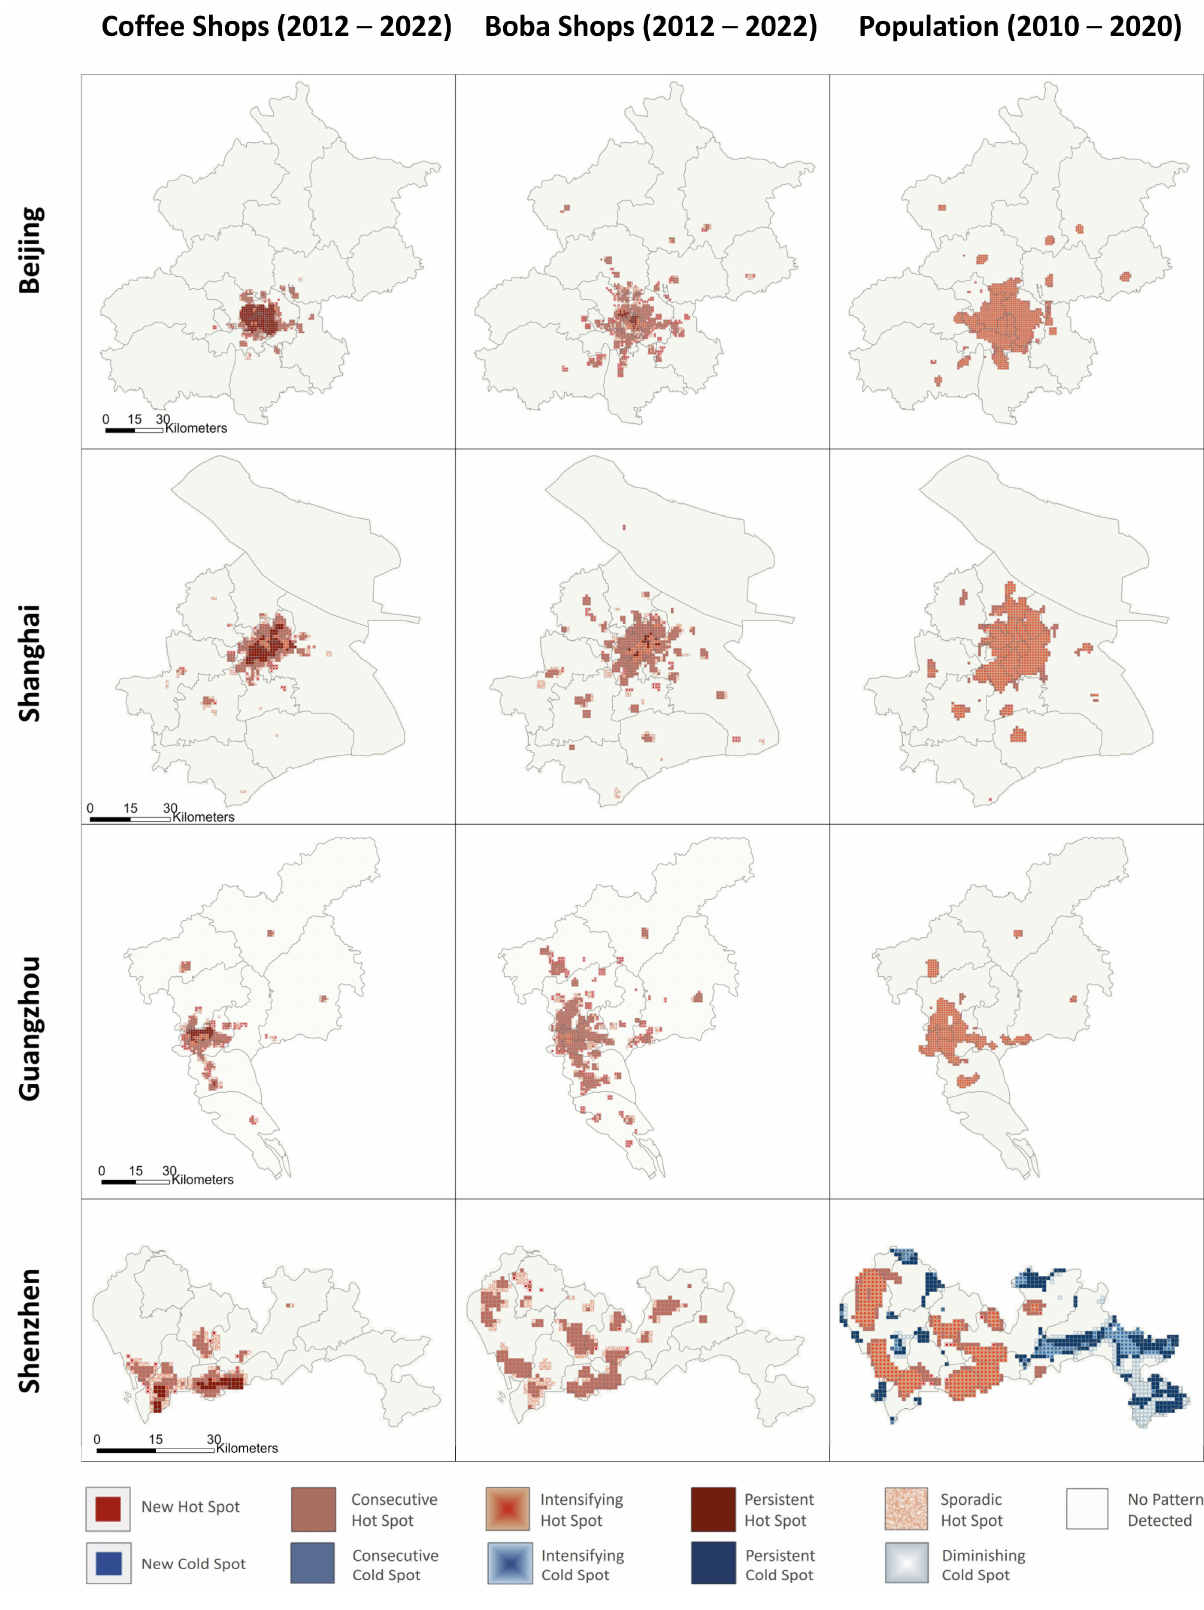
Figure 11. Emerging hot spot analysis results for population from 2010 to 2020 in four cities. On the one hand, coffee shops have more persistent hot spots than boba shops, mean- ing that there are more locations in which coffee shops have been consistently